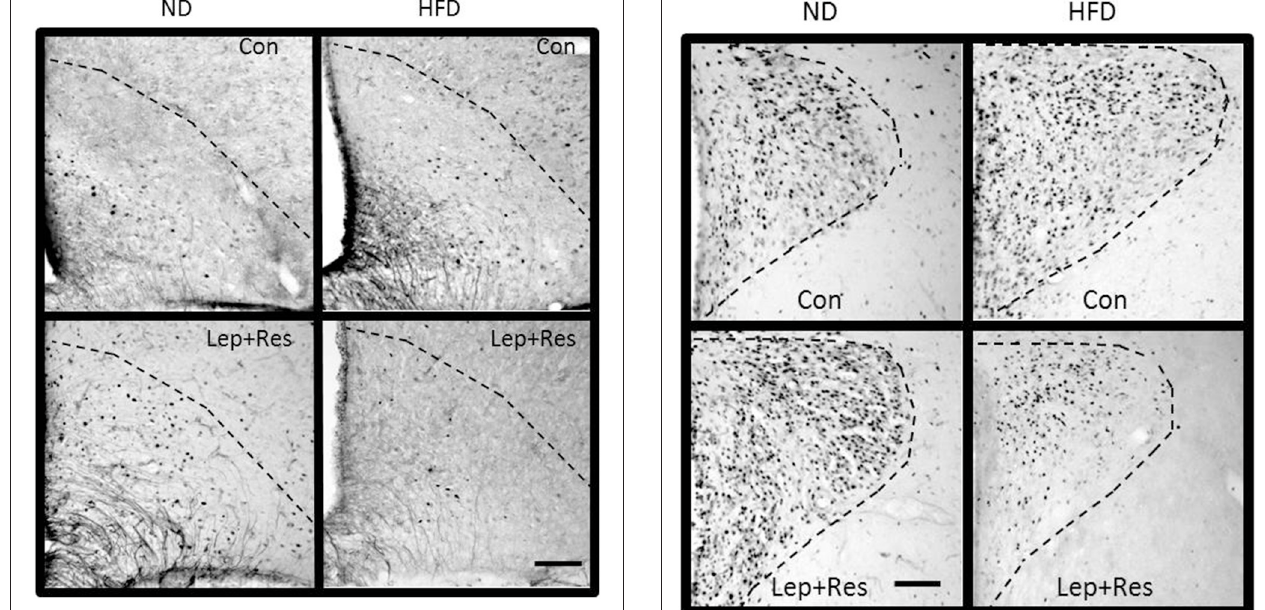
FIGURE 10 | Photomicrographs showing Fos-positive cell nuclei in the paraventricular nucleus (outlined by dashed lines) of rats fed a high fat diet (HFD) and rats fed a normal diet (ND) following centrally administered saline (5 µ l; control) or leptin combined with resistin (7 µ g). Scale bar = 100 µ m. The rostrocaudal levels of the sections counted were at ∼ 1.32–1.52mm caudal of